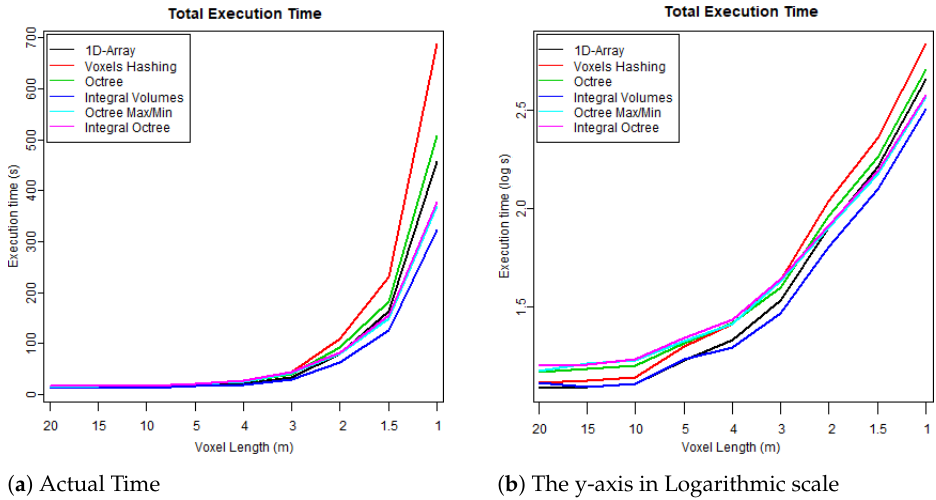
Figure 11. Total executable time including both construction and polygonisation (Table